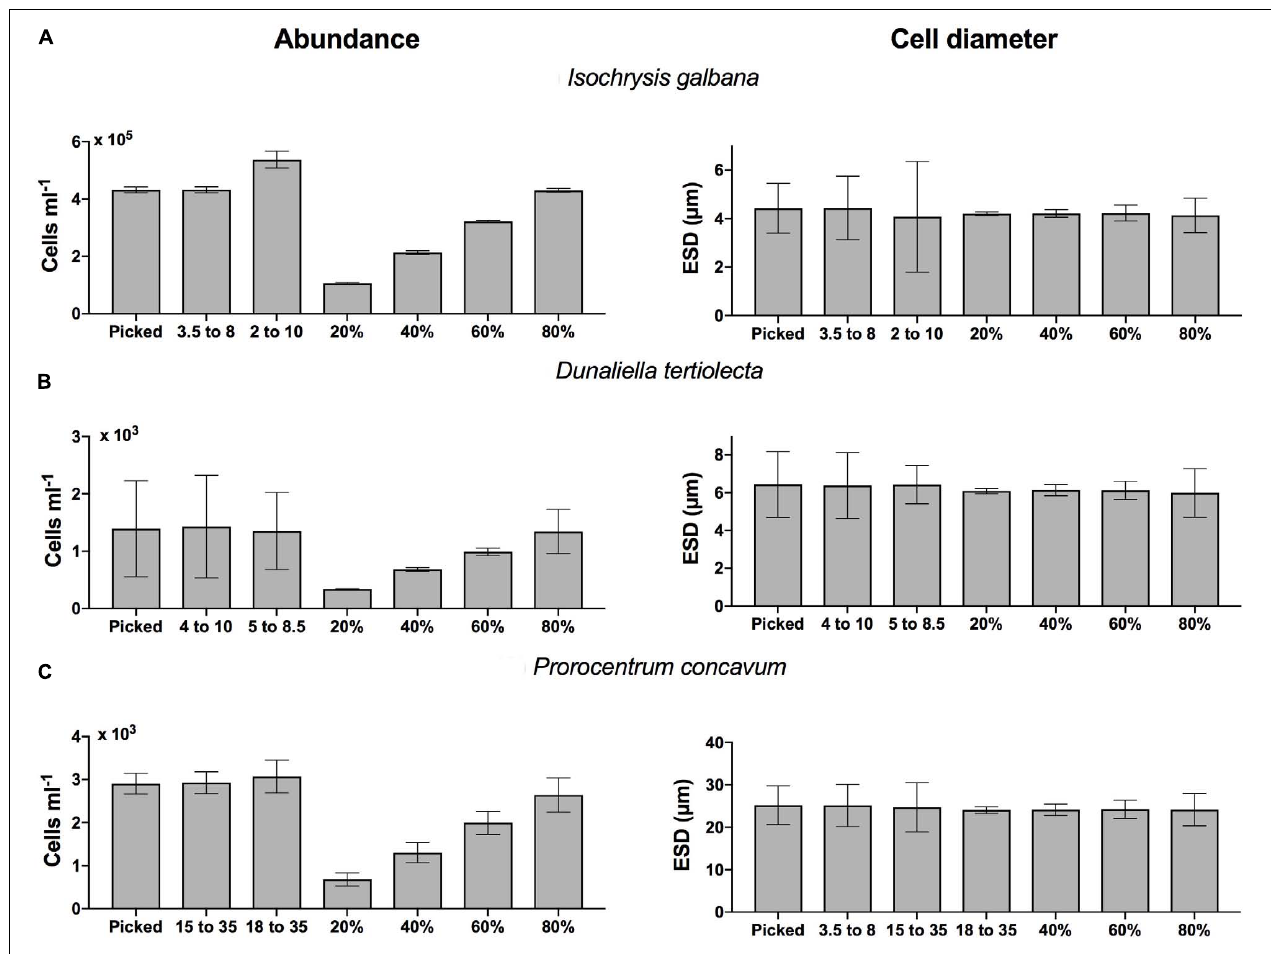
FIGURE 4 | (A–C) Abundance estimates (left panels) and size estimates (right panels) for the three focal phytoplankton species, (top A ) Isochrysis galbana, (middle B ) Dunaliella tertiolecta , and (bottom C ) Prorocentrum concavum , from an electronic particle analyzer (Coulter Counter), based on inclusion of different distribution ranges of the total particle size distributions, as indicated on the x-axis. “Picked” indicates a range as would be operator chosen using the CC software. Units are in µ m size range or fractions of the percentile